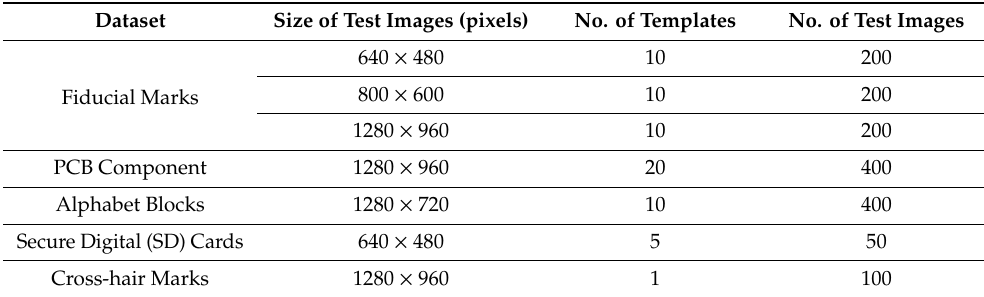
Table 1. Datasets are used to the evaluate performance of the RST